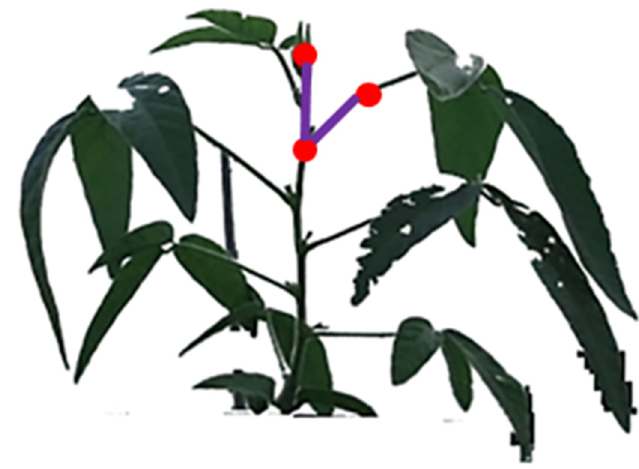
Figure 21. Diagram for calculating the angle of the leafstalk.